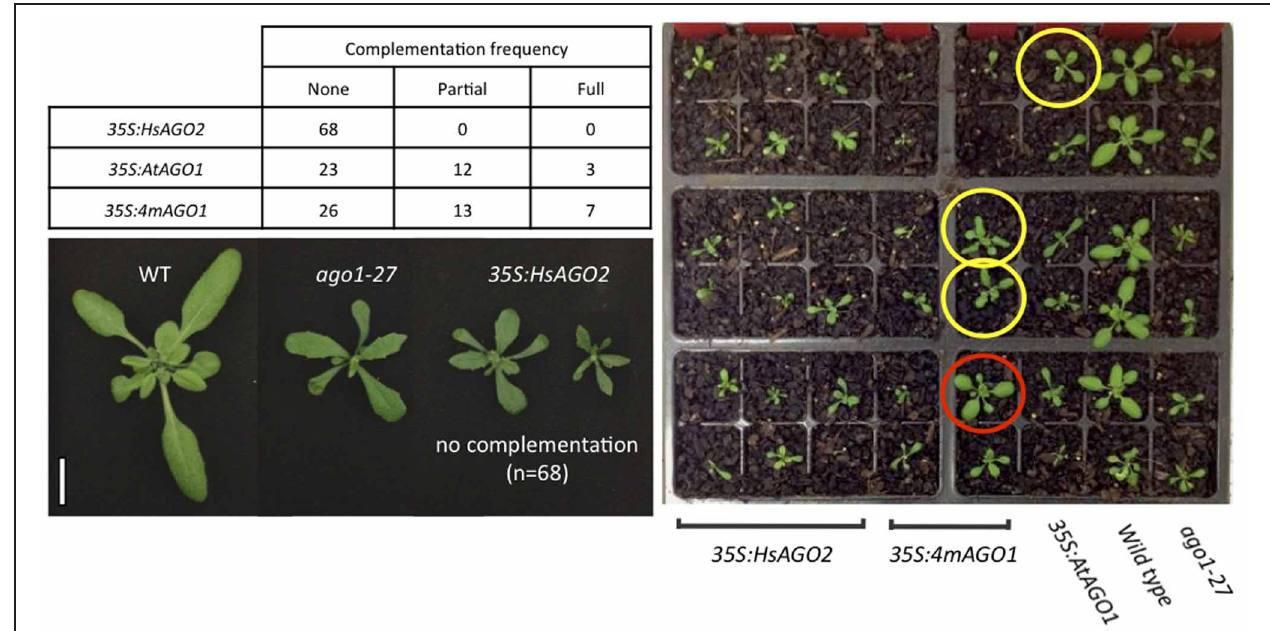
FIGURE 4 | HsAGO2 cannot complement the ago1–27 mutation. 22-day old transformants of 35S:HsAGO2 , 35S:AtAGO1, and 35S:4mAGO1 in the ago1–27 background were categorized based on their morphologies as being non-complemented (resembling ago1–27) , partially complemented (intermediate phenotype) or fully complemented (resembling wild type). The